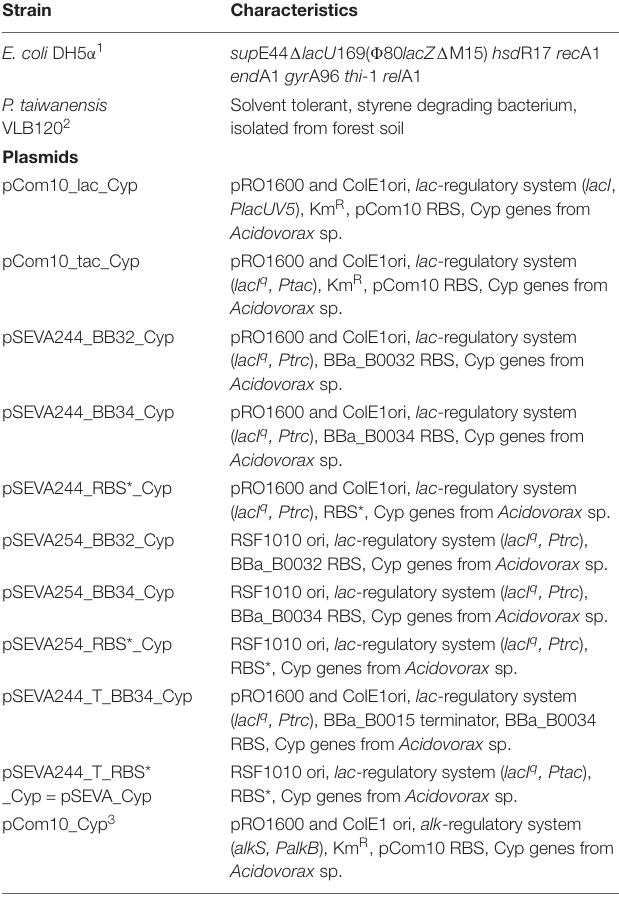
TABLE 1 | Strains and plasmids used in this